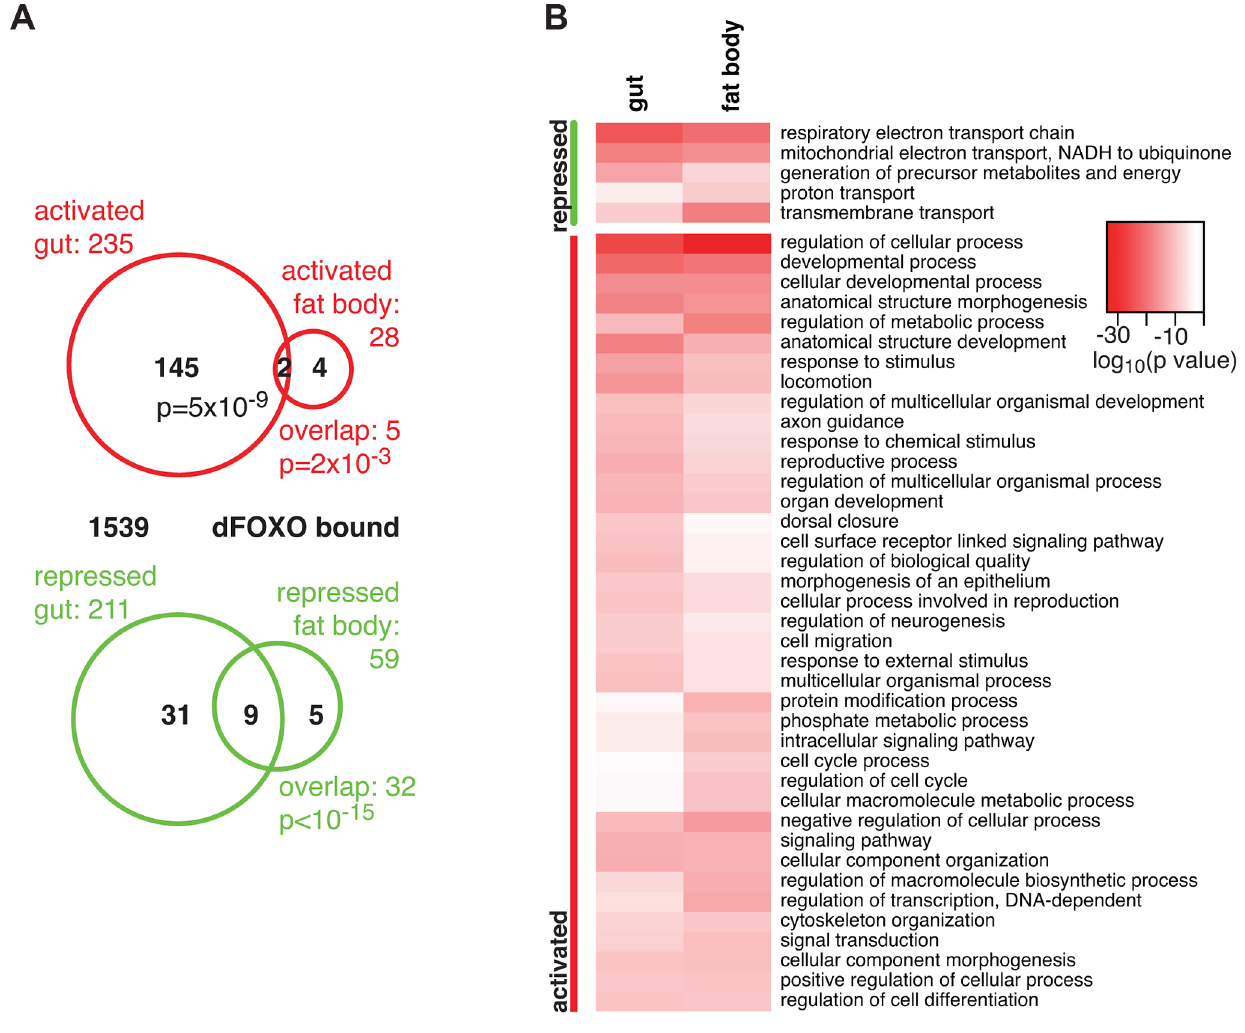
Figure 1. dFOXO targets in the adult gut and fat body. A Proportional Venn diagram showing the sets of genes that were differentially regulated by dfoxo induction in the gut or the fat body. The number of genes that were bound by GFP-dFOXO within each differentially expressed- gene set are given in black. p values for significant set overlaps are indicated. B Biological process GO categories differentially regulated (p , 10 2 10 ) in the fat body or gut upon induction of dfoxo as determined by Catmap analysis. Any redundant categories (overlap by more than 75%) were removed, retaining the most specific category. The full list is given in Dataset S1 . The intensity of red shows the log 10 -transformed p-value associated with differential regulation for each category.